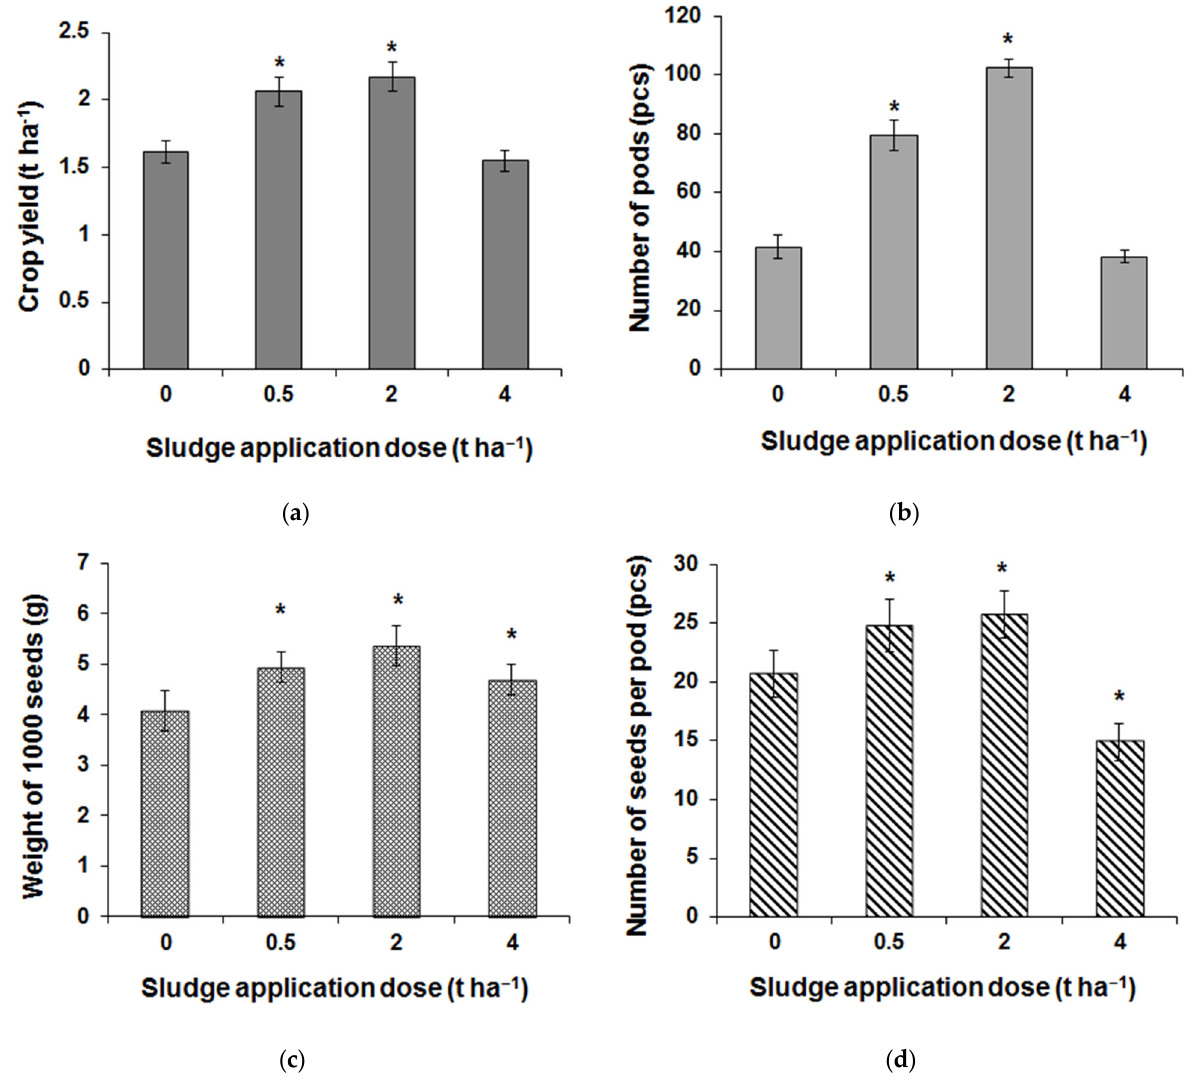
Figure 12. Rapeseed yield indicators. ( a – d ). *—significant differences with the control.